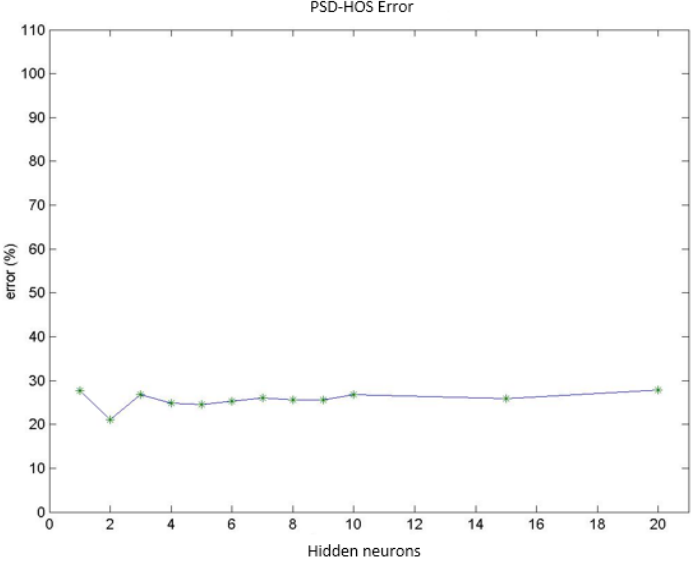
Figure 13. Diagnosis error (mean value) obtained using all parameters.